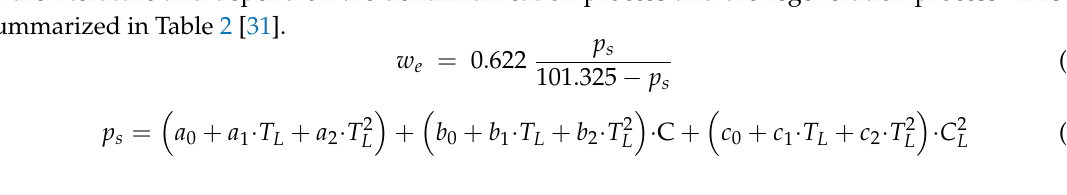
Table 2. The physical information of the model buildings studied